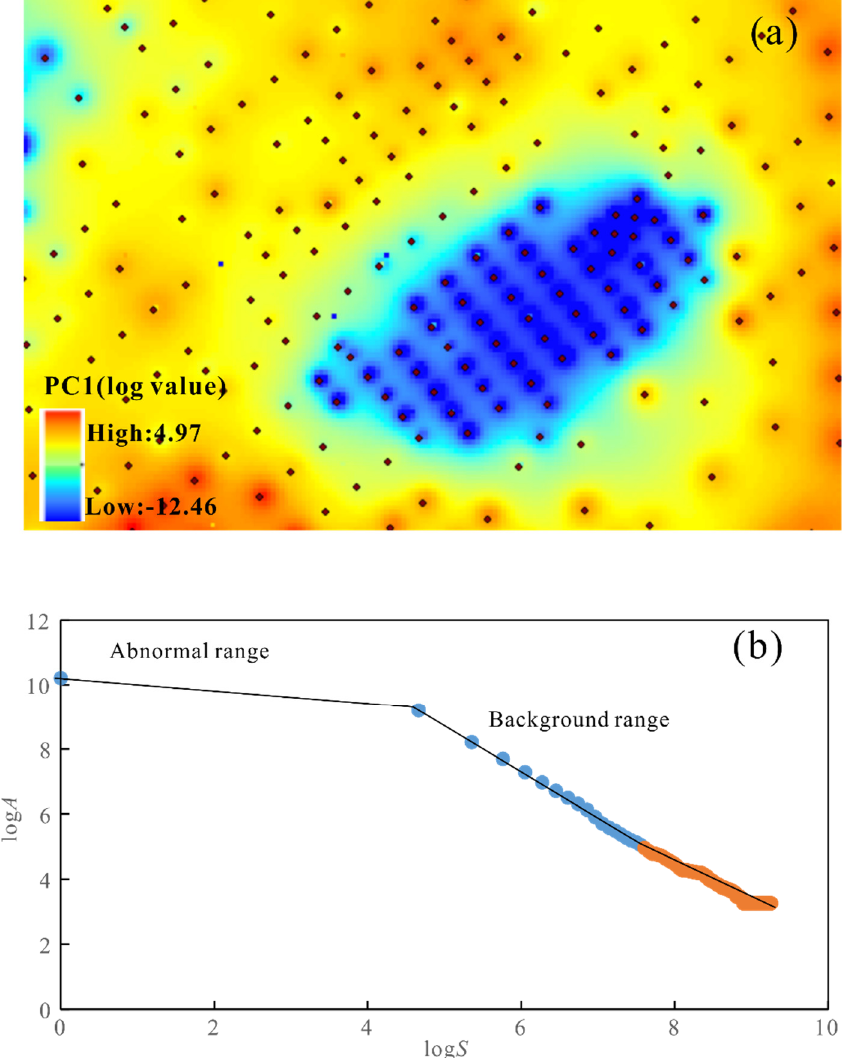
Figure 7. ( a ) Score map on the first principal component, ( b ) S-A plot. The corresponding energy spectrum of the dividing point is S = 1906. In ( b ), the straight line indicates that the anomaly has a fractal distribution, with the background distribution to the right and the dividing point automatically generated during the analysis.